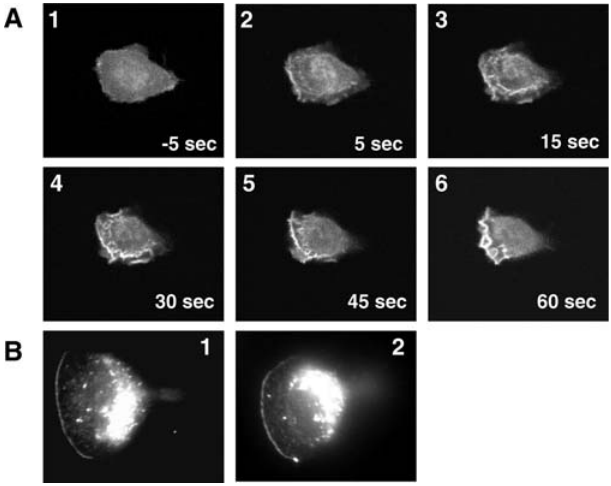
Figure 1. Hem-1 Strongly Polarizes following Uniform Stimulation of HL- 60 cells (A) Differentiated HL-60 cells expressing GFP-tagged Hem-1 were exposed to uniform 20 nM fMLP (at t ¼ 0 s) and imaged with a spinning disk confocal microscope at 5-s intervals at 37 8 C. See Video S1. (B) Human neutrophils obtained from finger pinprick [80] were exposed to uniform 20 nM fMLP for 3 min, fixed, and immunostained for endogenous Hem-1. Hem-1 immunostaining is observed at the leading edge of polarized cells (and also bright staining in the cytosol). DOI: